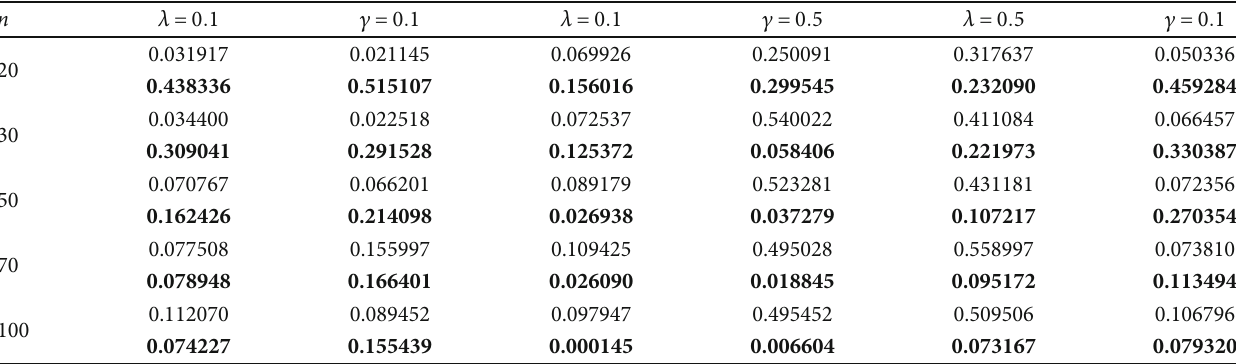
Table 7: BEs and PRs under QLF and informative prior using λ = 0 : 1, 0 : 5 and γ = 0 : 1, 0 : 5 .